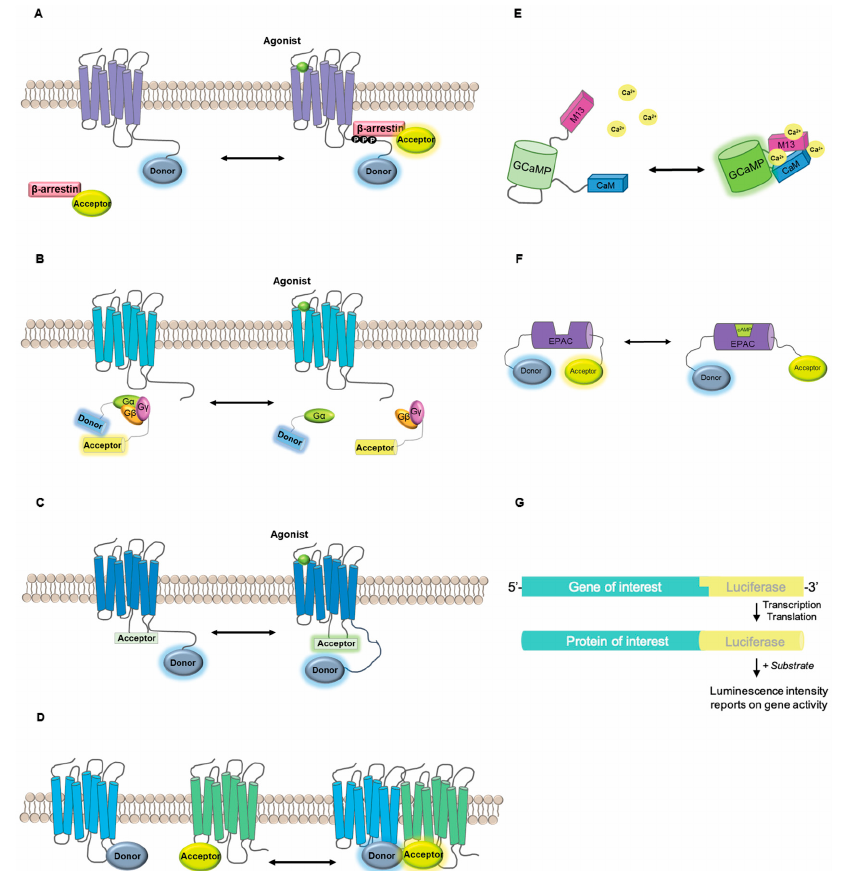
Figure 1. Common intensity, bioluminescent resonance energy transfer (BRET)- and fluorescent resonance energy transfer (FRET)-based biosensors. ( A ) Recruitment-based intermolecular biosensors. In this example, G protein-coupled receptors (GPCR) activation results in β -arrestin recruitment to the phosphorylated receptor. Tagging the receptor of interest with a donor moiety and β -arrestin with a compatible acceptor fluorophore allows us to study the recruitment of arrestins to activated GPCRs. In the absence of agonist, the donor- and acceptor-tagged proteins are far apart and no RET can be detected. Upon agonist induction, β -arrestin is recruited to the receptor at the cell surface resulting in a quantifiable RET event. ( B ) Dissociation-based intermolecular biosensors. GPCR activation results in the dissociation of the heterotrimeric G proteins, G αβγ ; more specifically, the distancing of G α from G βγ . Fusion of fluorescent or bioluminescent tags on G α and on G γ allow us to study the activation of a GPCR upon agonist stimulation. ( C ) Conformation-sensitive biosensors that report on GPCR conformational dynamics. The highly dynamic nature of GPCRs can be studied by inserting reporter proteins within the coding sequence of the receptor of interest. For instance, fluorophores or motifs specific for fluorescent dyes can be introduced with the intracellular loops of receptors along with a C-terminally fused compatible RET donor. Agonist stimulation can result in the conformational rearrangement in the receptor structure which can be measured by relative changes in the distance/orientation of the chromophores. ( D ) Protein–protein interaction sensors. In order to detect whether two proteins exist in close proximity within the cell, they can be tagged with RET compatible fluorophores, and their interaction can be assayed as described above. ( E ) Intensity-based biosensor GCaMP. This biosensor contains a circularly-permutated fluorophore (GFP) along with the calcium binding domain of calmodulin protein and the M13 domain of myosin light chain kinase. In the absence of calcium, the GFP chromophore is protonated and in a low fluorescence form. In response to calcium binding to the calmodulin domain, a conformational change allows chromophore de-protonation and recovery of fluorescence. ( F ) Conformation-sensitive biosensors that report on intracellular signaling events. These biosensors are synthetic proteins designed to undergo a conformational change in